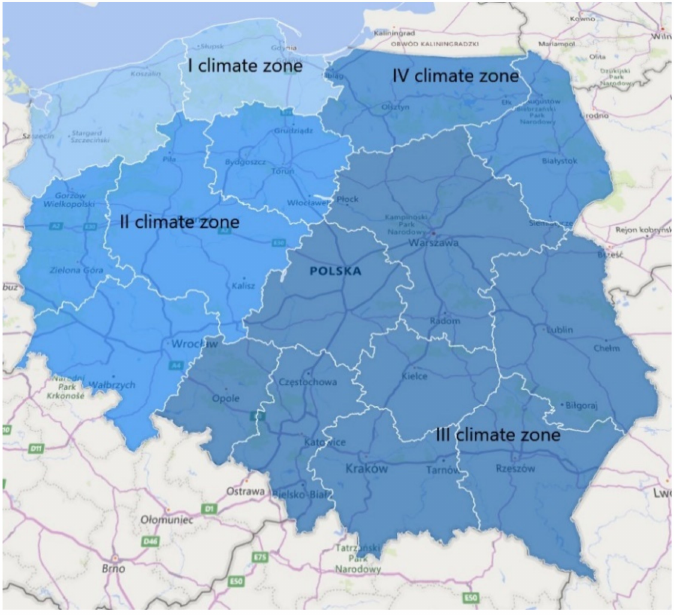
Figure 1. Map of climate zones in